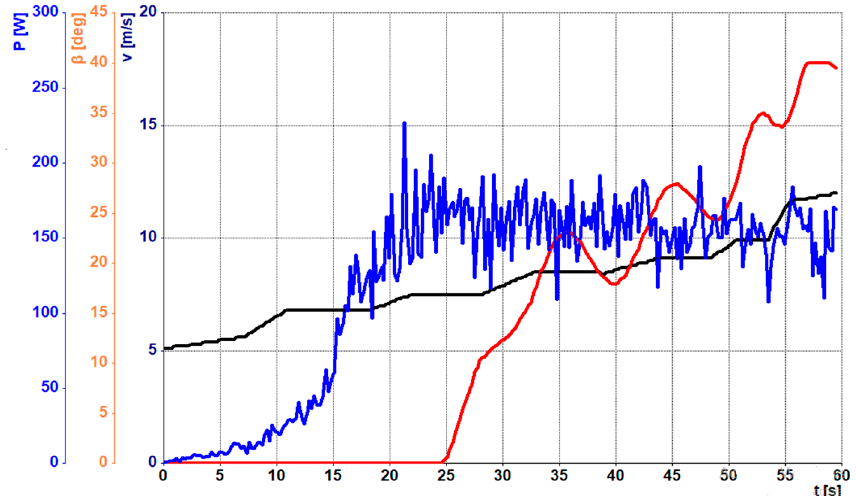
Figure 7. Wind speed, active power, and blade angle of third experimental case study.